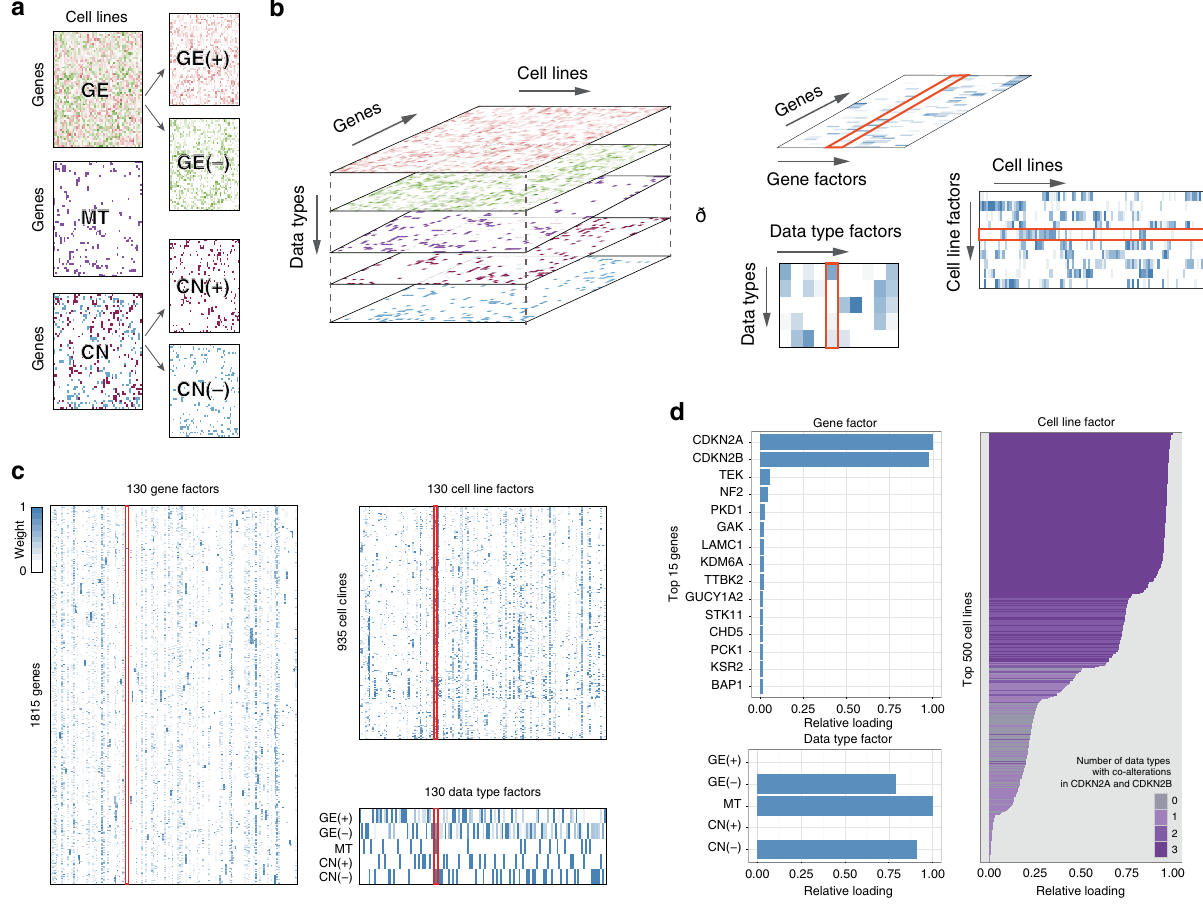
Fig. 1 The framework of WON-PARAFAC. a Individual data types represented in genes-by-cell-lines matrices with matched gene and cell line indices across the data types in which mixed sign data (i.e. gene expression and copy number) are split into two positive matrices. b Data cube formed by stacking the fi ve matrices, where the modes span genes, cell lines, and data types. WON- PARAFAC produces three sparse factor matrixes for each of the modes: gene factor (gene-factor), cell line factor (cell-factor) and data type factor (DT-factor) matrix. c The three sparse factor matrices from WON-PARAFAC as heatmaps, with the 41st factor highlighted. d 41st factor loadings of top 15 genes (gene-factor; top left), data types (DT-factor; bottom left), and top 500 cell lines (cell-factor; right). Color of bars in the bar plot for cell-factor indicates the number of data types with CDKN2A and CDKN2B altered in